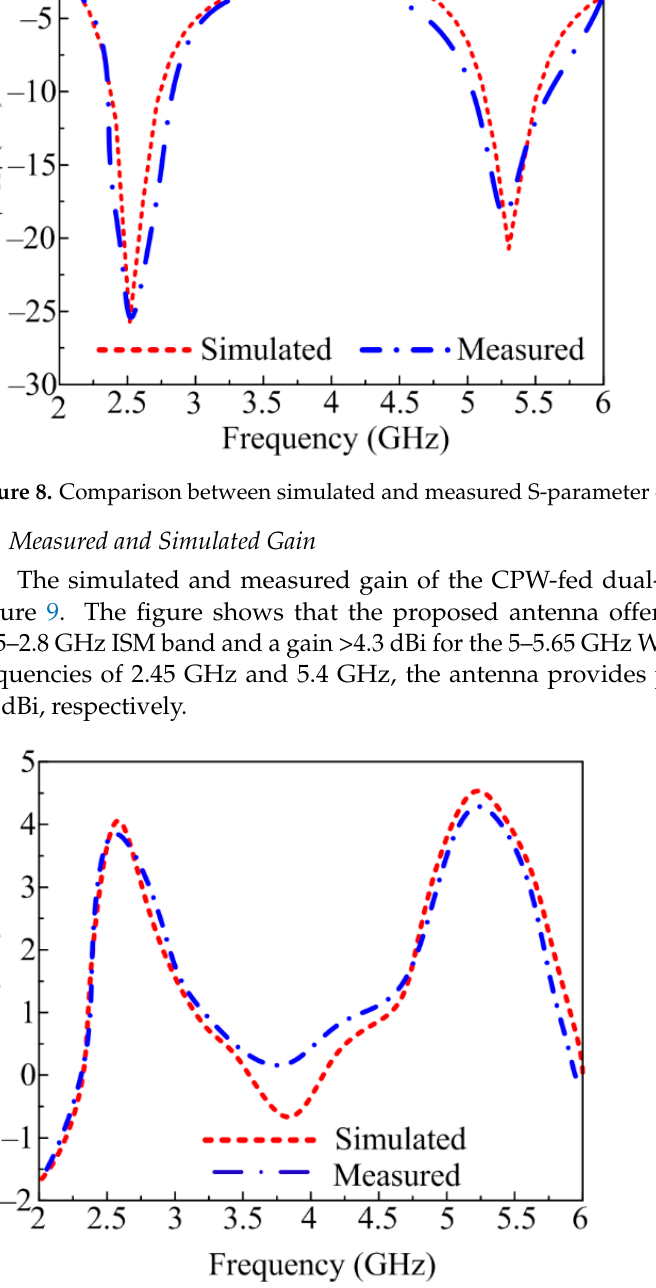
Figure 9. Comparison between measured and simulated gain of suggested antenna.